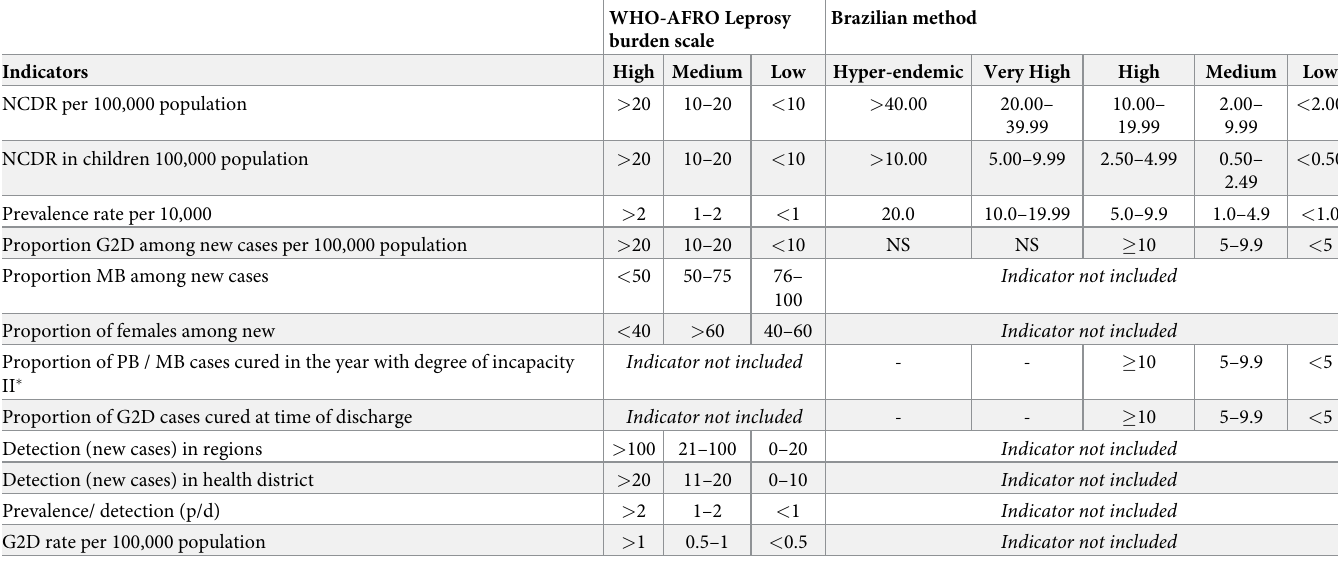
Table 1. Existing frameworks for classifying endemicity and burden using pre-defined levels, indicators, and cut-offs.